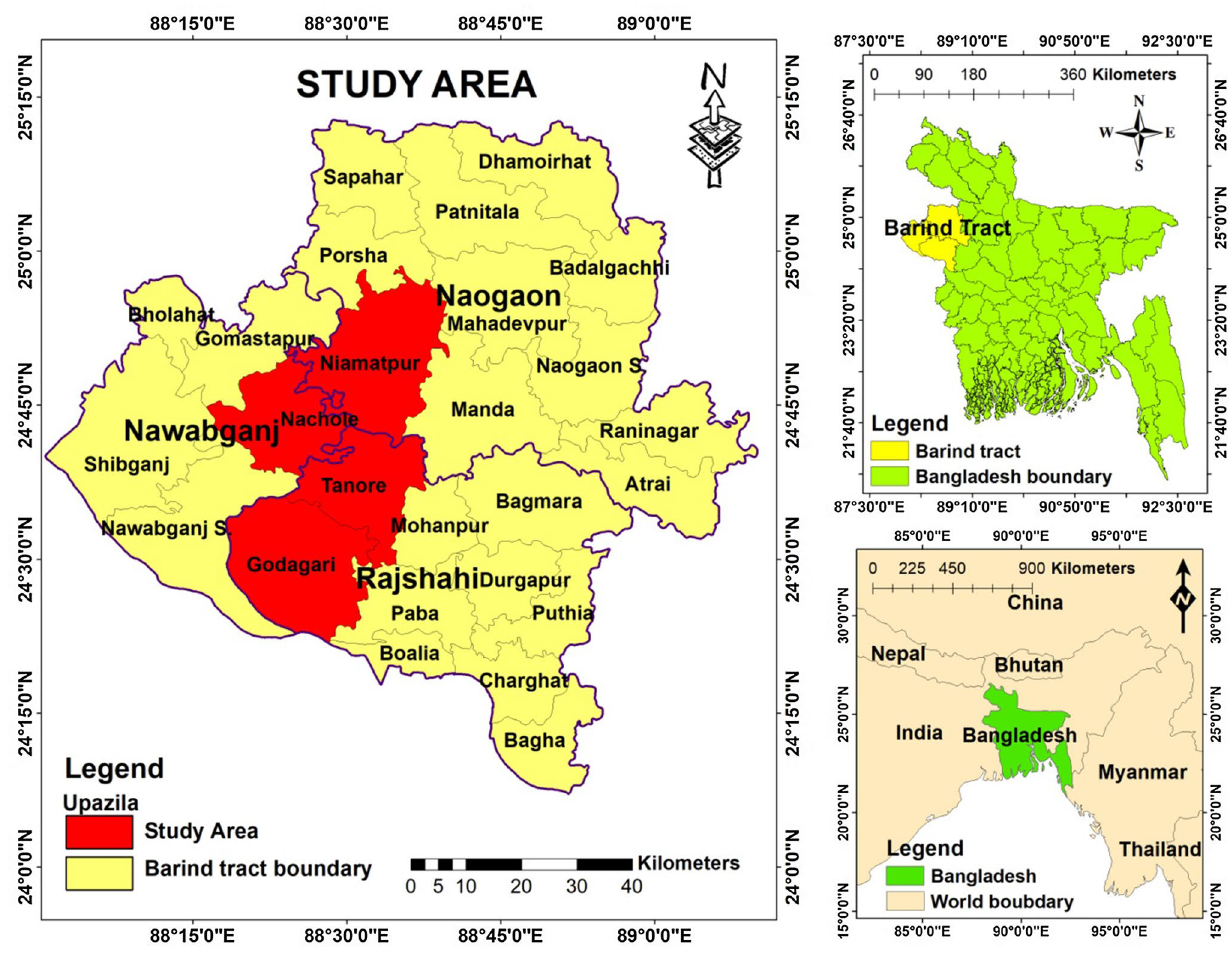
Fig. 1 Location map of the study